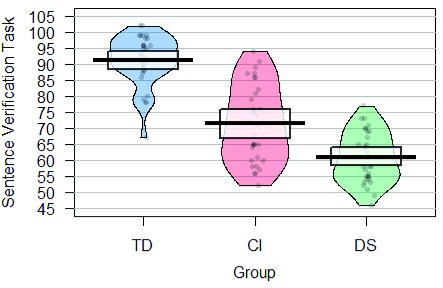
Pirate plot (
Phillips, 2016) of the performance of each group on the sentence verification task (TECS-E).The points represent the raw data (jittered horizontally), the bars show the means, with the surrounding rectangle showing the Bayesian 95% Highest Density Interval for the mean. Each dataset is enclosed by a smoothed density plot.